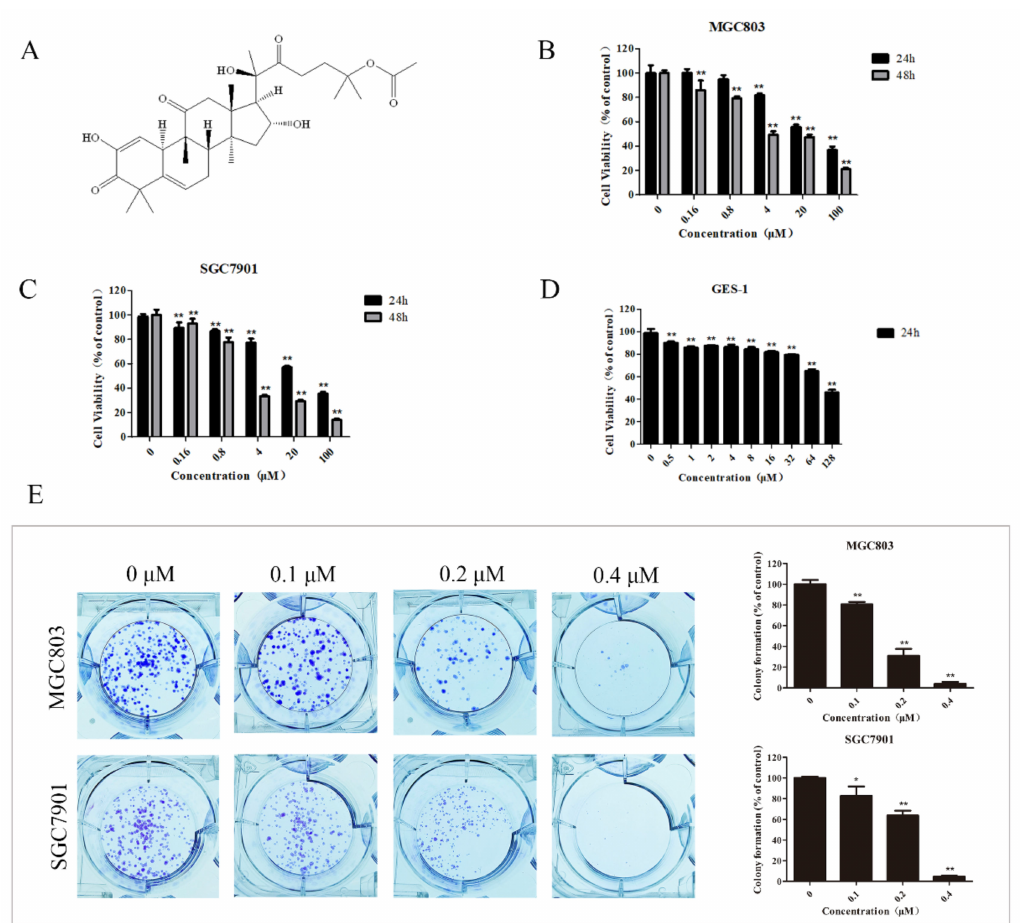
Figure 1. 23,24-dihydrocucurbitacin E (DHCE) effectively suppressed the proliferation of gastric cancer cells. ( A ) Chemical structure of DHCE. ( B , C ) MTT assay of cell viability in MGC803 and SGC7901 cells treated with DHCE (0–100 µ M) for 24 and 48 h, respectively. ( D ) MTT assay of cell viability in normal gastric epithelial (GES-1) cells treated with DHCE (0–128 µ M) for 24 h. ( E ) Clones in MGC803 and SGC7901 cells treated with DHCE (0, 0.1, 0.2, or 0.4 µ M) for 10 days in a colony formation assay and the statistic results of colony formation assays. The experiment was performed in triplicate, and the statistical results are expressed as means ± SD (* p < 0.05 and ** p < 0.01 compared with the control